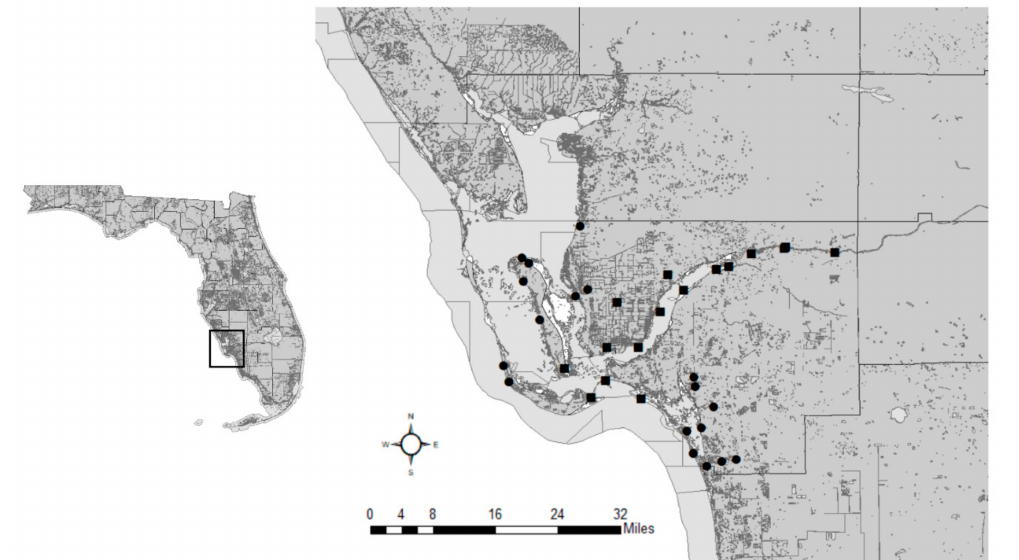
Figure 3. Map of Florida and location of boat ramps in Lee County. Ramps represented by squares experience cyanobacteria harmful algae blooms originating from Lake Okeechobee discharges. Boat ramps represented by circles are assumed not to be impacted by cyanobacteria algae